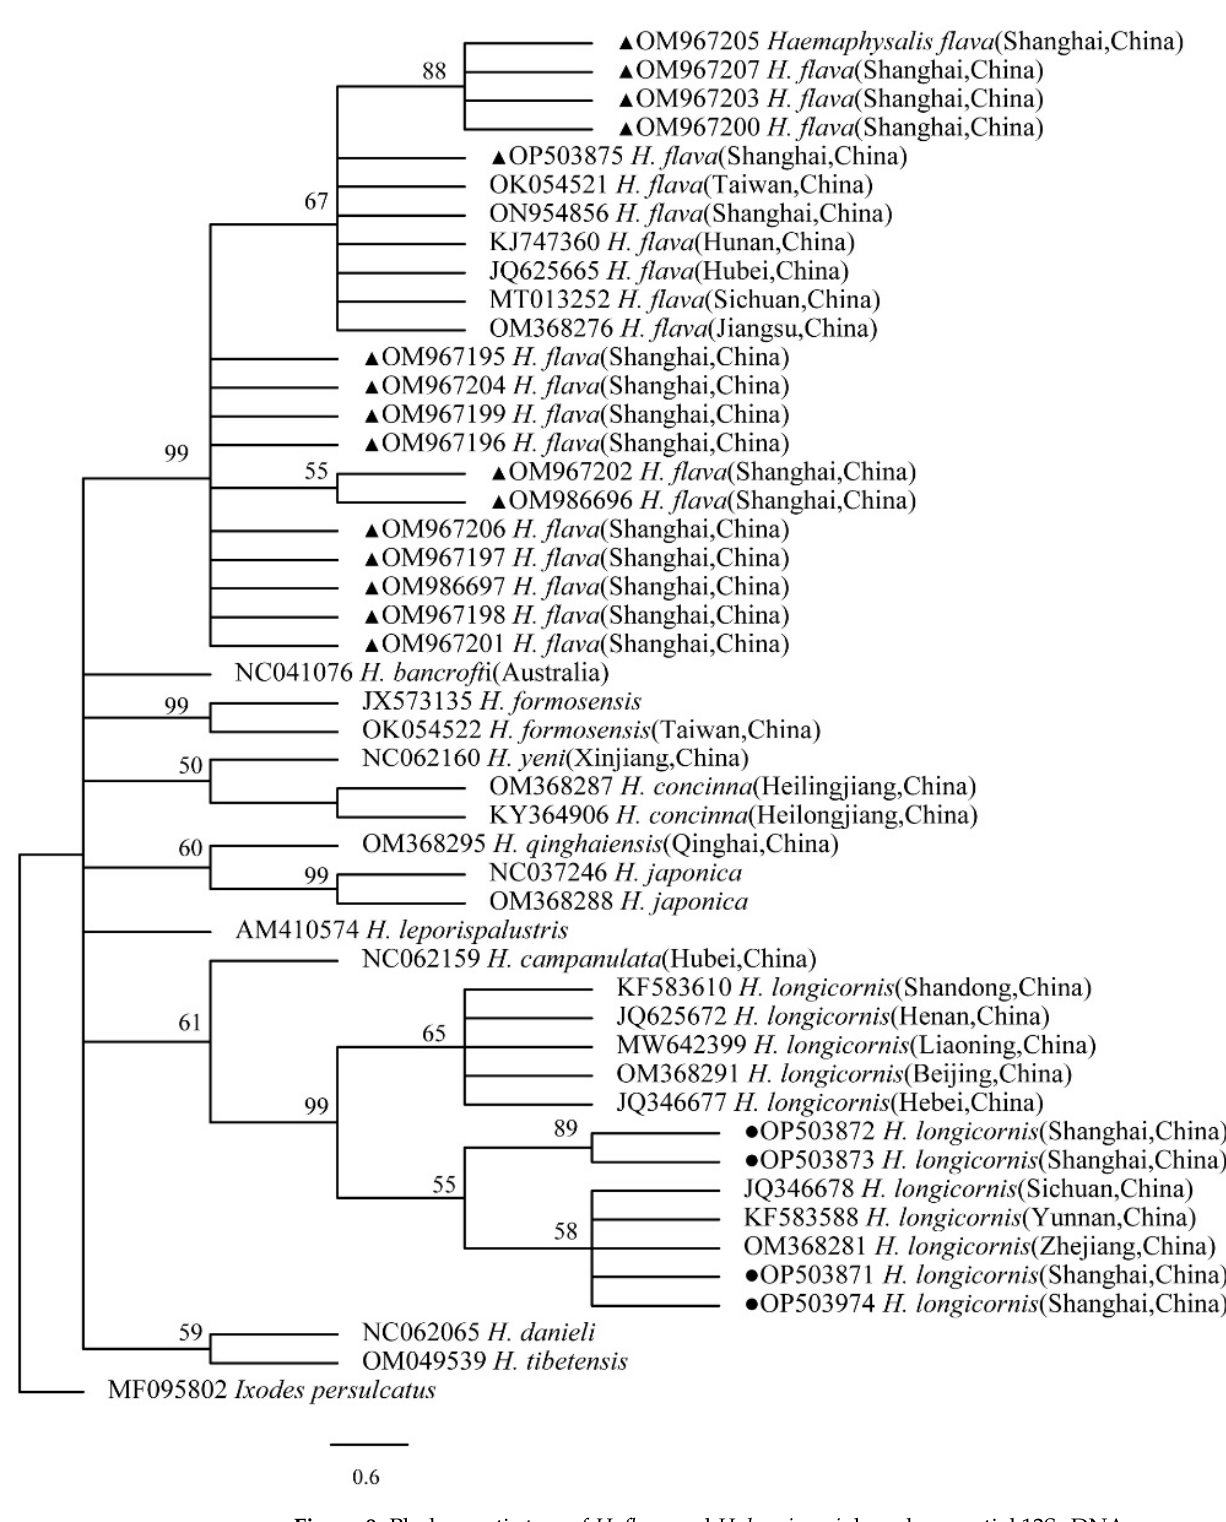
Figure 9. Phylogenetic tree of H. flava and H. longicornis based on partial 12S rDNA gene sequence similarity. The sequence from H. flava obtained in this study is indicated with a black triangle, and the sequence from H. longicornis obtained in this study is indicated with black dots. Sequences were aligned using the MEGA X (version 10.0) software package. Phylogenetic analysis was performed by the neighbor-joining method (NJ method), and bootstrap values were estimated for 1000 replicates. Kimura’s two-parameter model was used as a substitution model for the calculation of the phylogenetic trees.